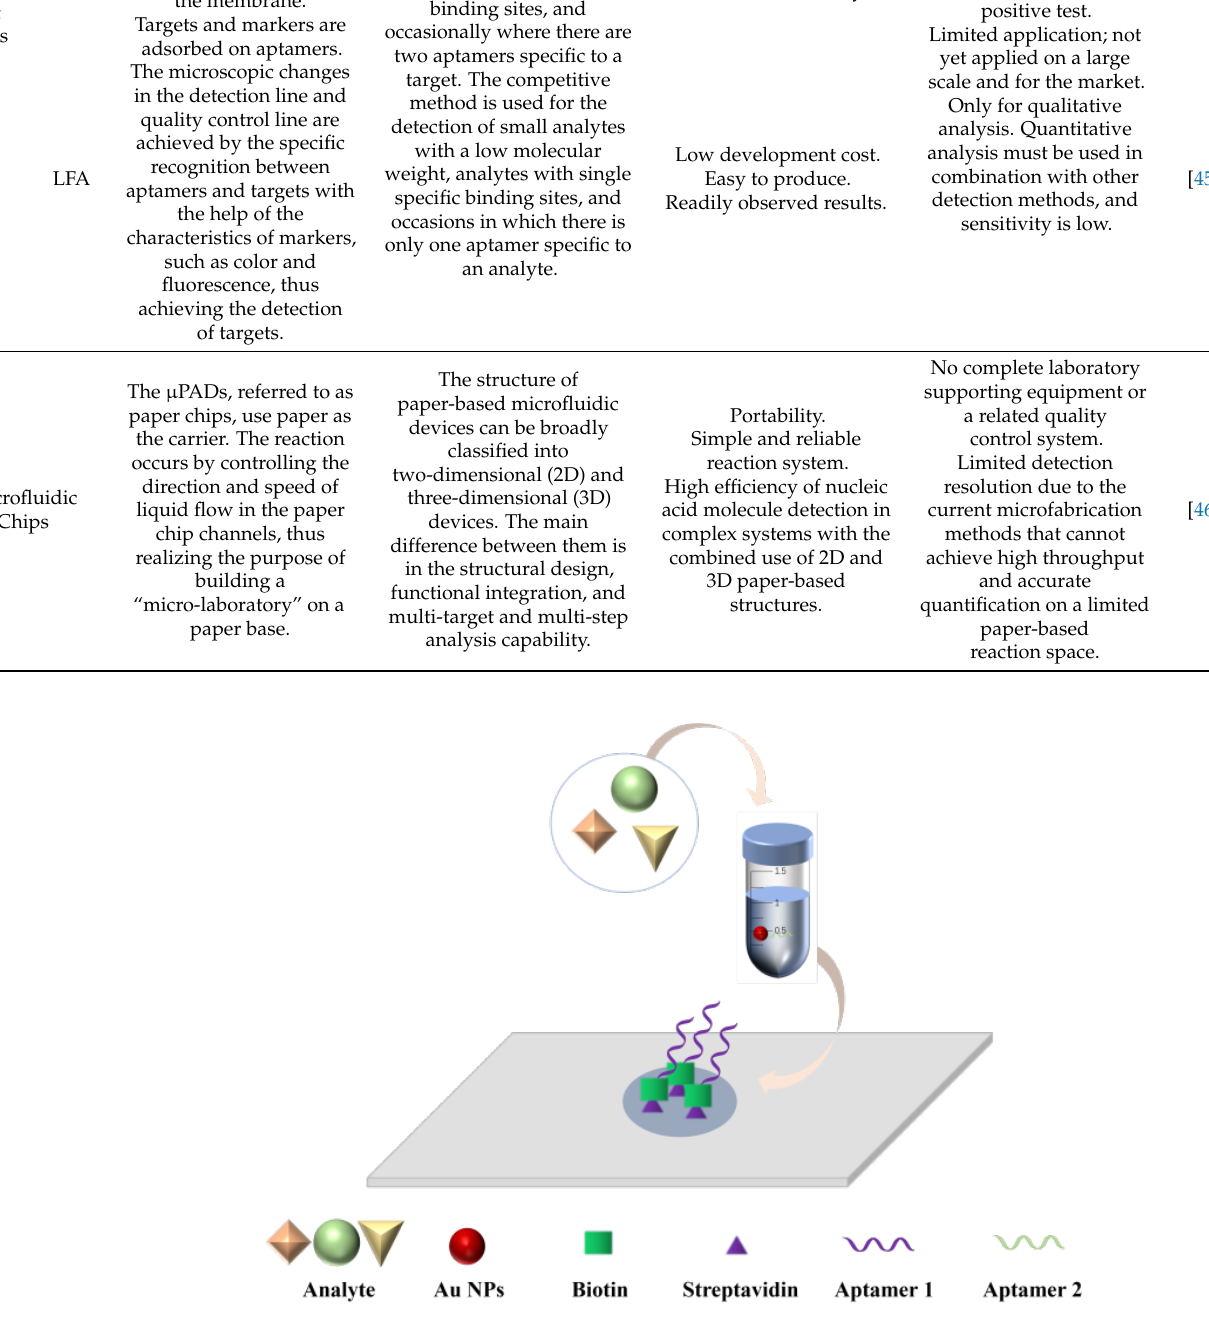
Figure 1. Schematic diagram of the Au-NPs based dot filtration assay. Lateral Flow Assay